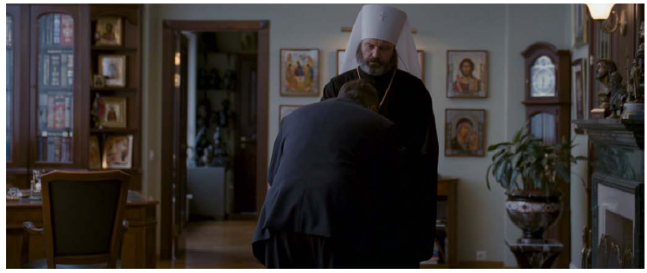
Figure 11. Leviathan (2014).